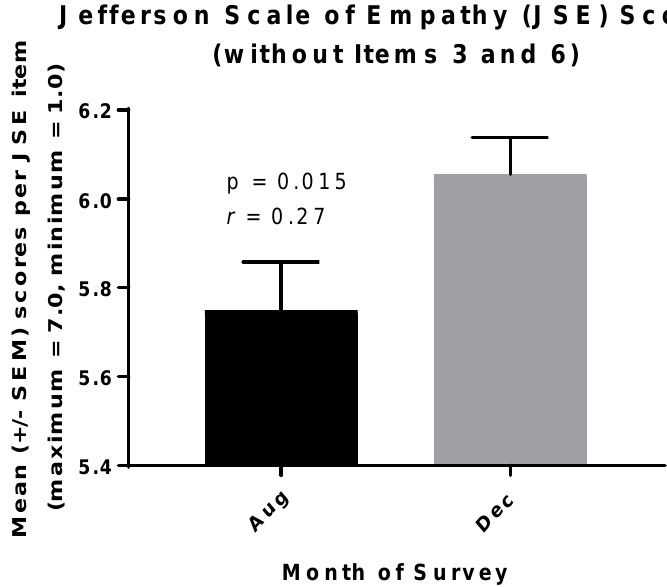
Figure 2. An increase in the cognitive empathy (JSE) scores of prospective medical (MSBS) students occurred in association with the rise in their reflective capacity (RC) scores (Figure 1) between August and December 2019.